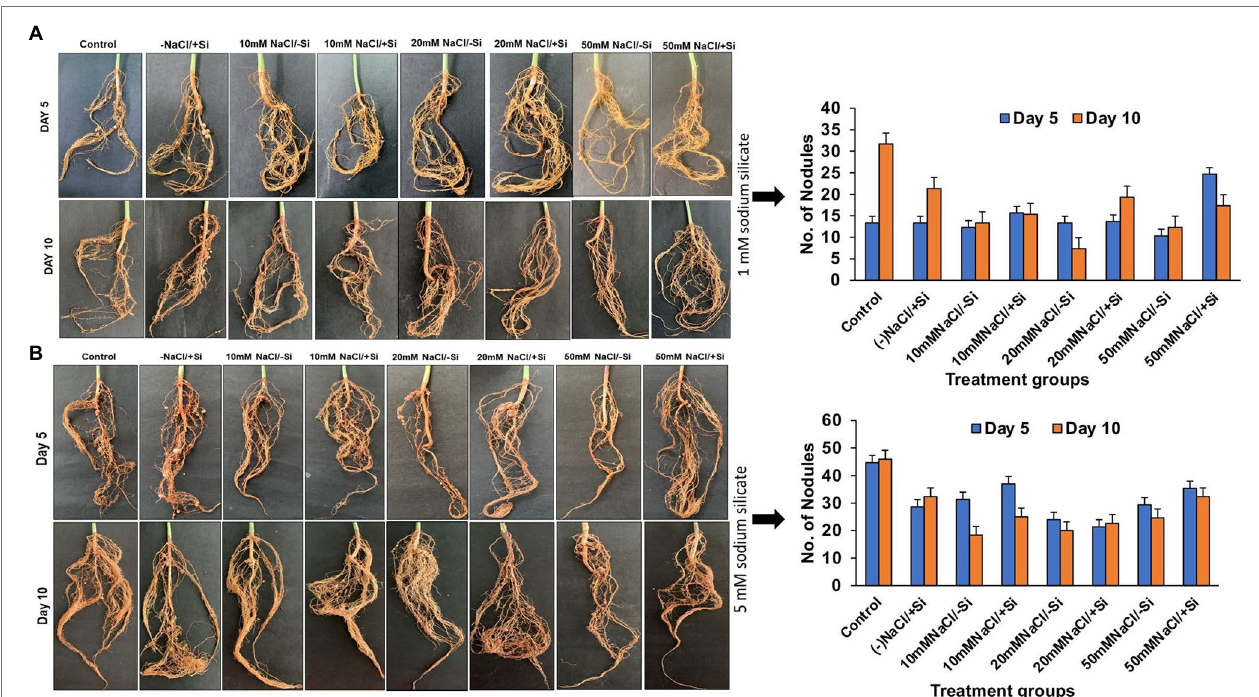
FIGURE 2 | Changes in the formation of root nodules of mung bean ( Vigna radiata ) under (A) 1 mM (Si 1 ) and (B) 5 mM (Si 2 ) Si supply and salinity stress after eight treatments: (i) control (T1), (ii) − NaCl+Si (1 mM/5 mM) (T2), (iii) 10 mM NaCl/ − Si (T3), (iv) 10 mM NaCl/+ Si (1 mM/5 mM) (T4), (v) 20 mM NaCl/ − Si (T5), (vi) 20